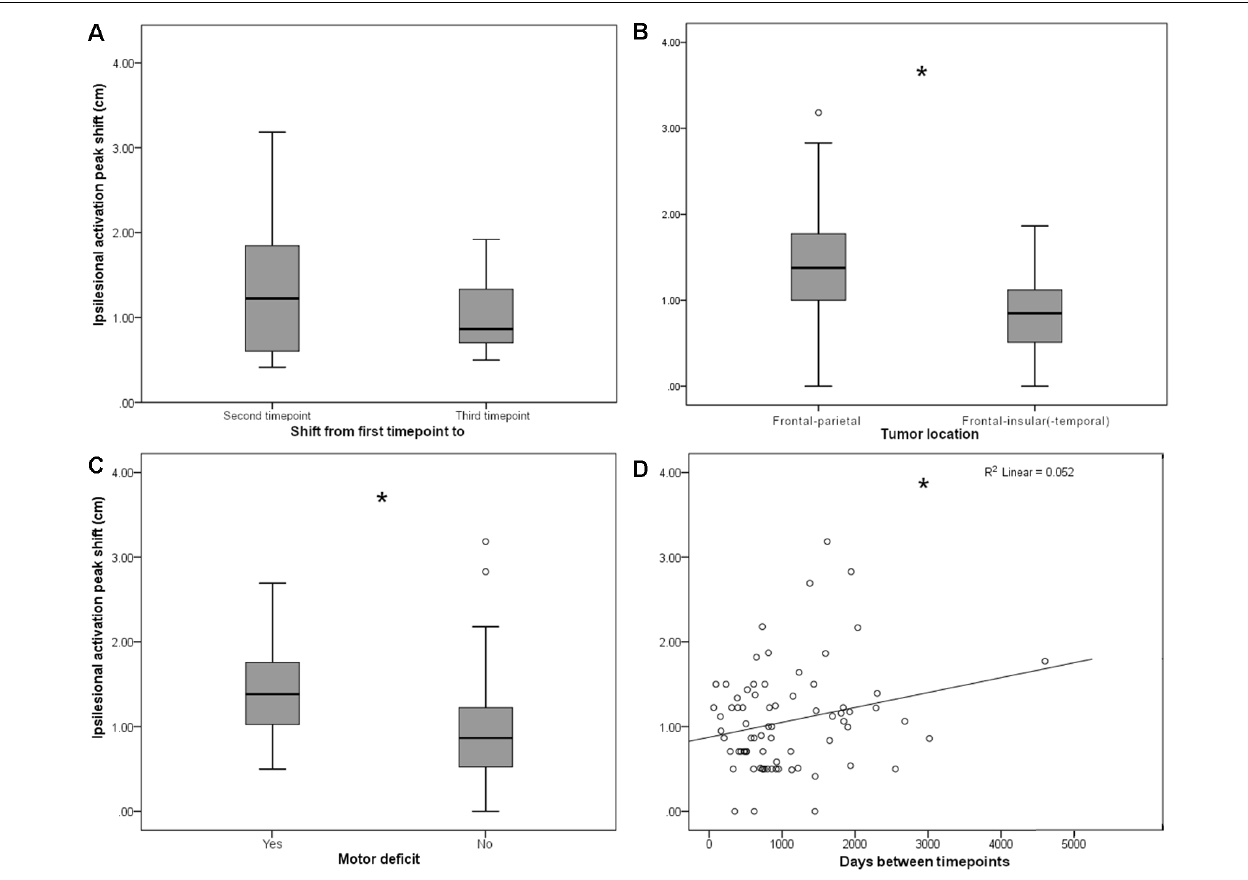
FIGURE 2 | (A) Persistent shifts are observed with longer follow-up times. Box plot shows Euclidian distance shift from first to second and from first to third time point, respectively, in the subgroup ( n = 11) of patients with observations from three time points. No significant difference was observed. (B) Ipsilesional MC peak shifts are greater in perirolandic regions. Box plot shows Euclidean distance-based shifts in the activation peak in tumors exceeding into the frontal and/or parietal lobes, as opposed to tumors exceeding predominantly into frontal-insular and/or temporal lobes. Patients with frontal/parietal tumors showed largest primary MC shifts ( t (73) = 4.38; p < 0.001). (C) Ipsilesional MC peak shifts are greater for patients with motor deficits. Box plot shows Euclidian distance shifts in the activation peak for patients with or without motor deficits. Patients with motor deficits showed larger primary MC shifts ( t (73) = − 2.36; p = 0.021). (D) Shifts show linear time-dependence between scans. Effect of days between the first and the second time point on the activation peak shift. Days between timepoints accounted for 5.2% of the variance in activation peak shift with a regression equation of 0.88 + 0.18*10 − 3 , showing a direct correlation of days between timepoints and ipsilesional MC shifts ( F (1,73) = 4.04, p = 0.048; fitted regression line R 2 = 0.052). * p <